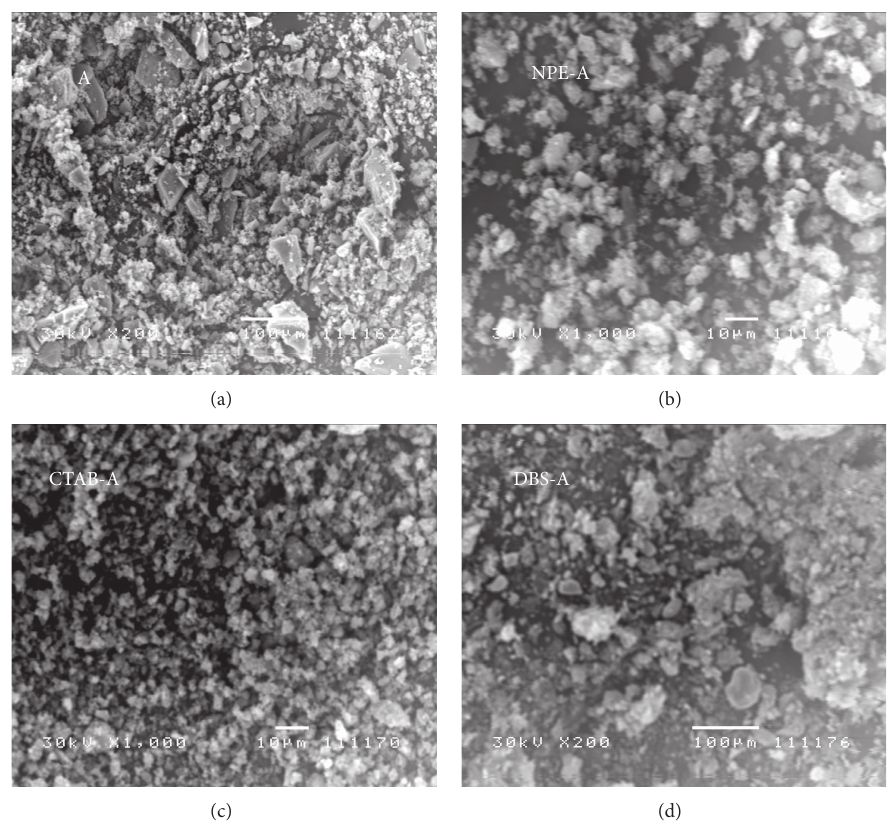
Figure 5: SEM images of the TiO 2 without and with different surfactants at pH 3-4.